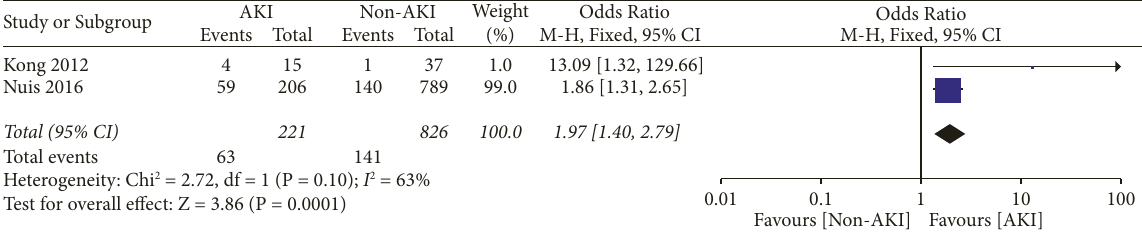
Figure 6: Meta-analysis of one-year all-cause mortality in AKI versus non-AKI patients after TAVR.